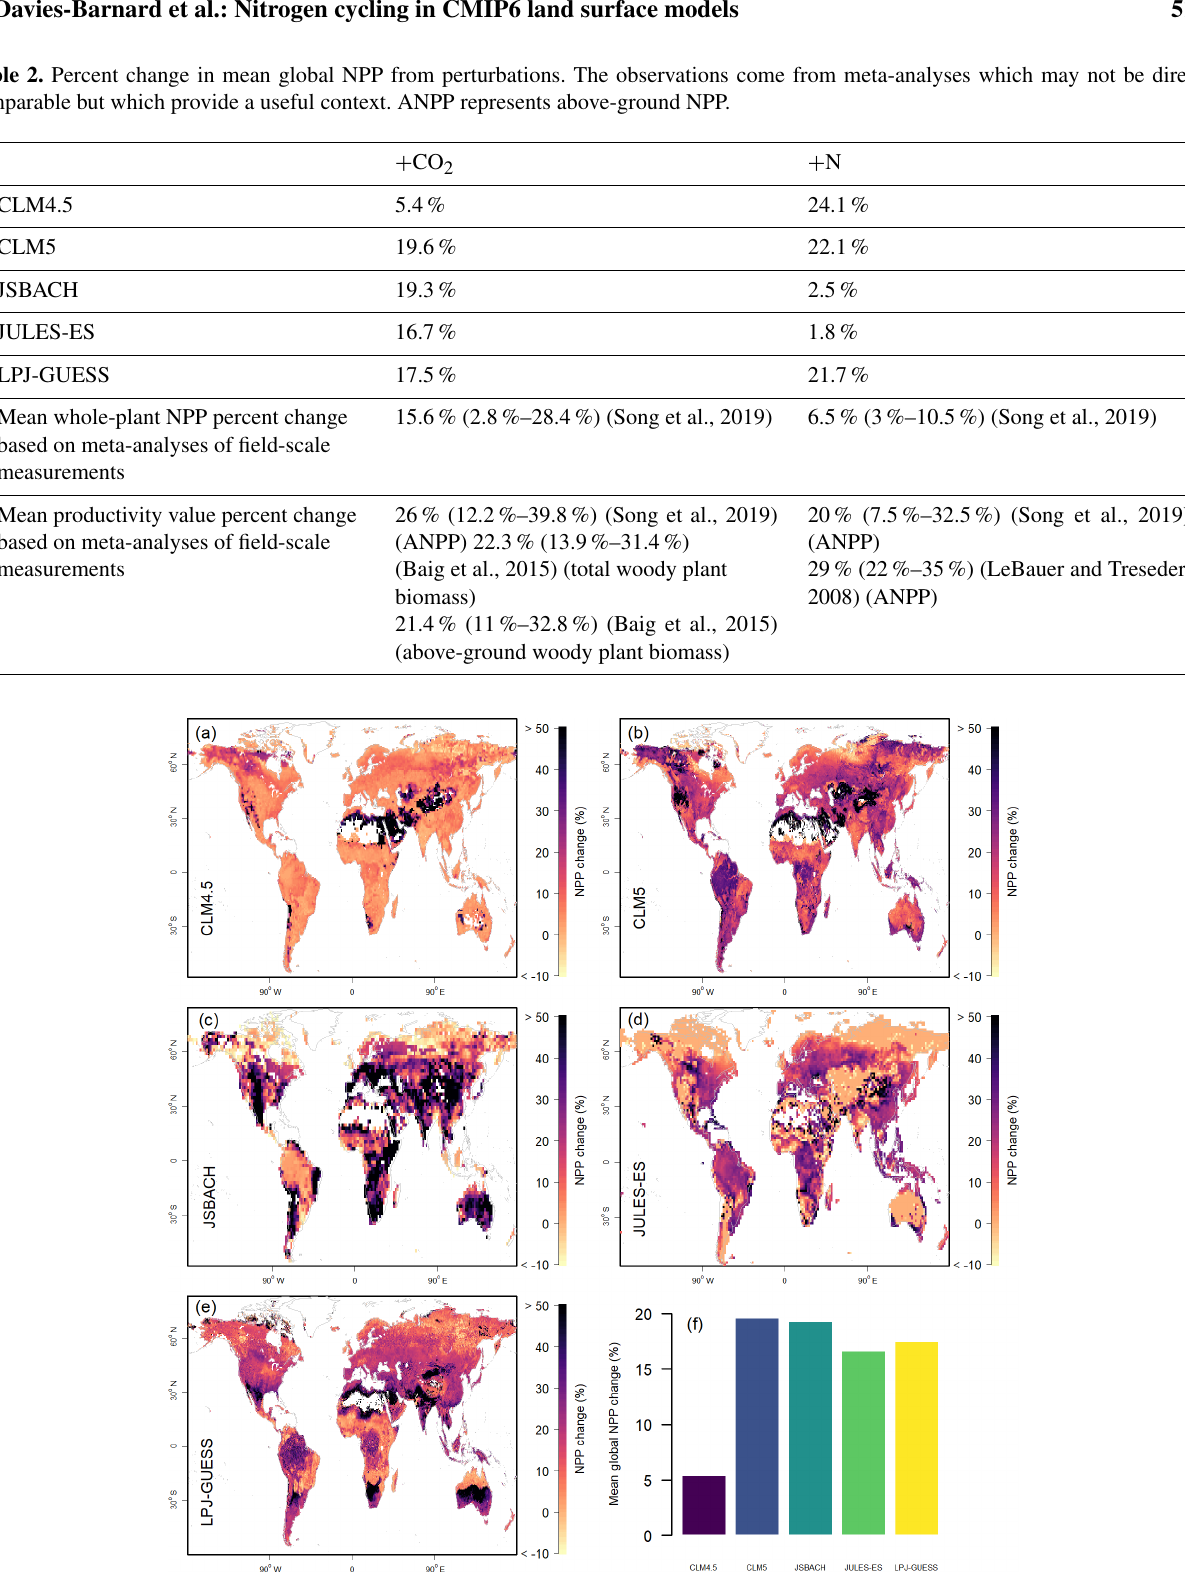
Figure 2. Model estimates of 1996–2005 mean net primary productivity (NPP) response to + CO 2 . (a–e) Model estimates, shown as the anomaly compared to the model control scenario. Values above 50% are given the 50% colour. (f) Global percent change in mean